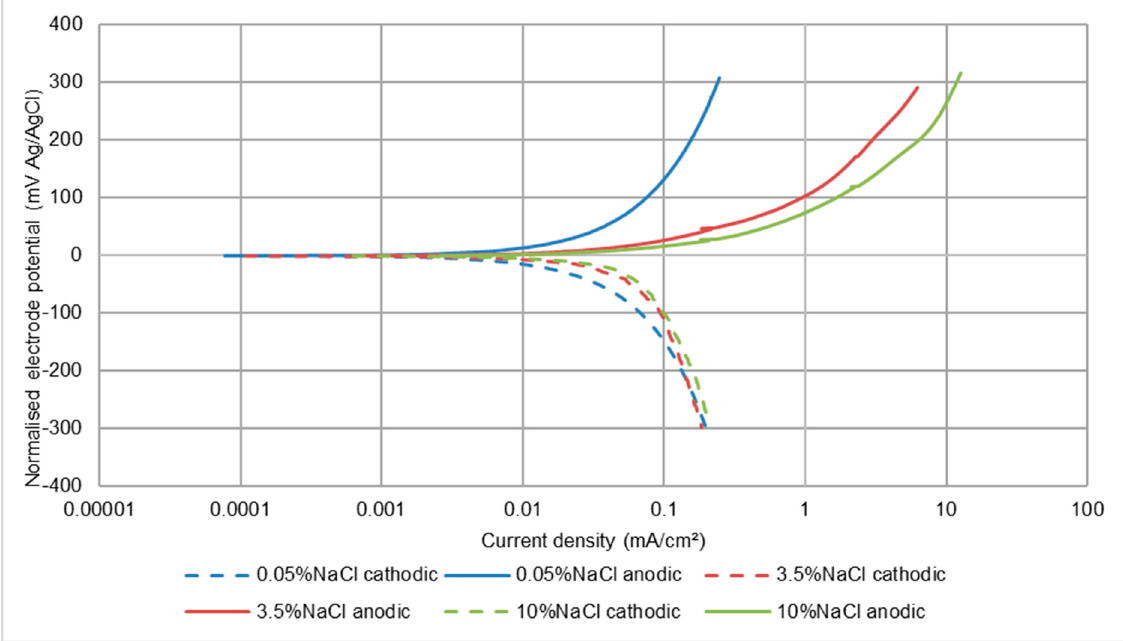
Figure 10. Polarisation plots for UNS G43400 steel under LEC conditions (no solids).